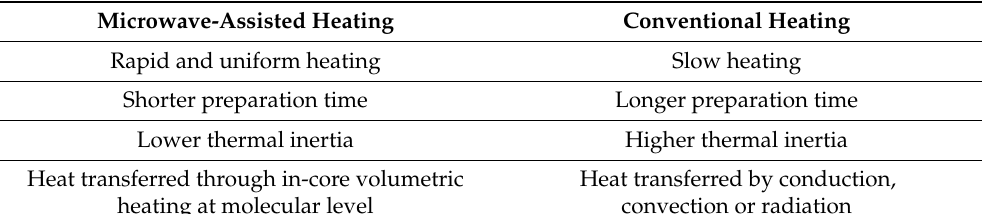
Table 2. Comparison between microwave-assisted and conventional heating